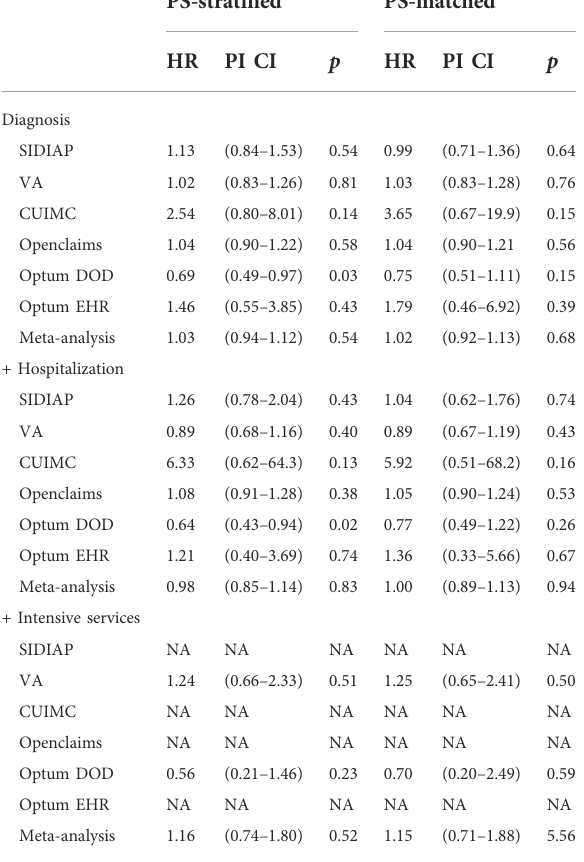
TABLE 3 Hazard ratios of COVID-19 diagnosis, hospitalization, and intensive services for alpha-1 blocker and 5ARI/PDE5 prevalent- use. We report calibrated hazard ratios (HRs) and their 95% con fi dence intervals (CIs) and calibrated p -value ( p ), with PS strati fi cation or matching and across data sources. Grayed out entries do not pass study diagnostics and are excluded from the